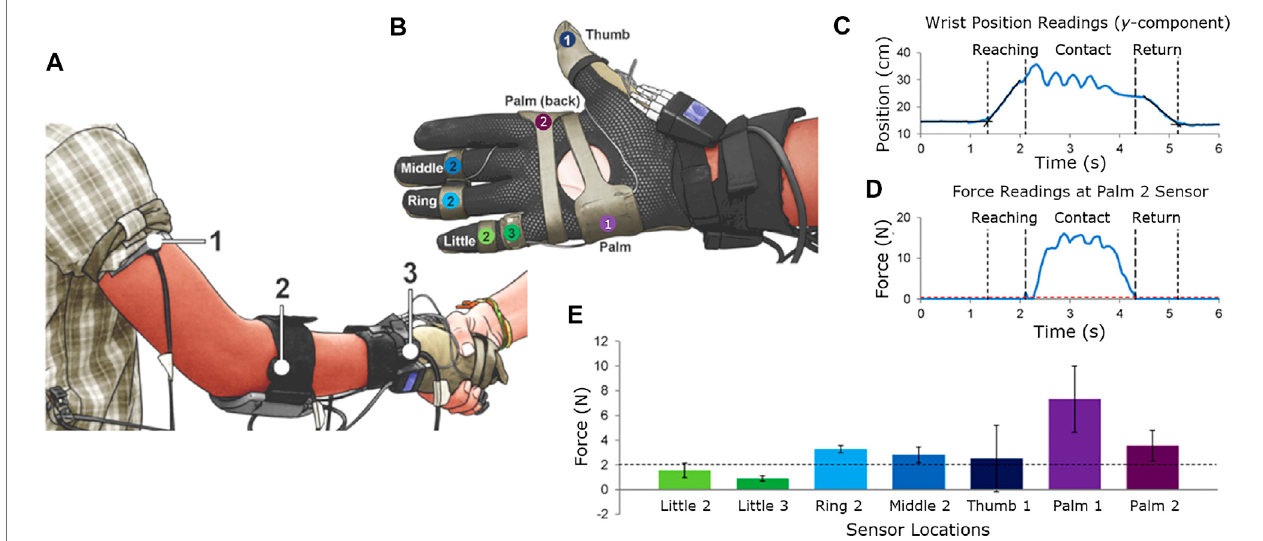
FIGURE1| Locationsandnumberingofthemotiontrackingsensors. (A) Sensors1,2,and3arelocatedontheupper-armbelowtheshoulderjoint,ontheforearm below the elbow joint, and on the wrist joint, respectively. (B) Locations and average readings of the force sensors and determination of movement and contact durations.Thelocationsoftheforcesensorsareshown. (C,D) Theproceduresfordeterminingthestartandendofmovementandcontactforthe fi rstdatasetareshown. (E) The mean contact forces of each force sensor.